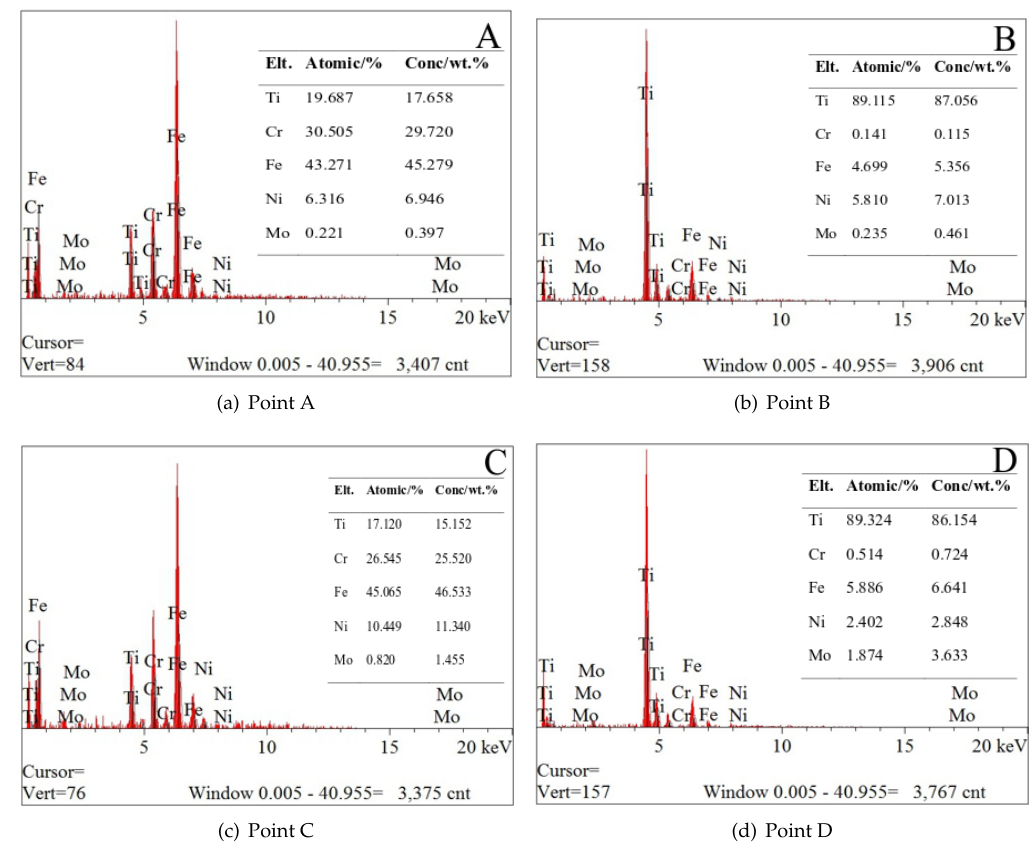
Figure 13. EDSresults at interested points of clad